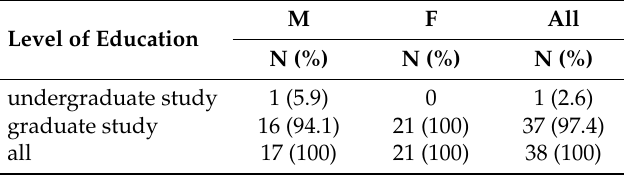
Table 3. “Choose the highest level of your